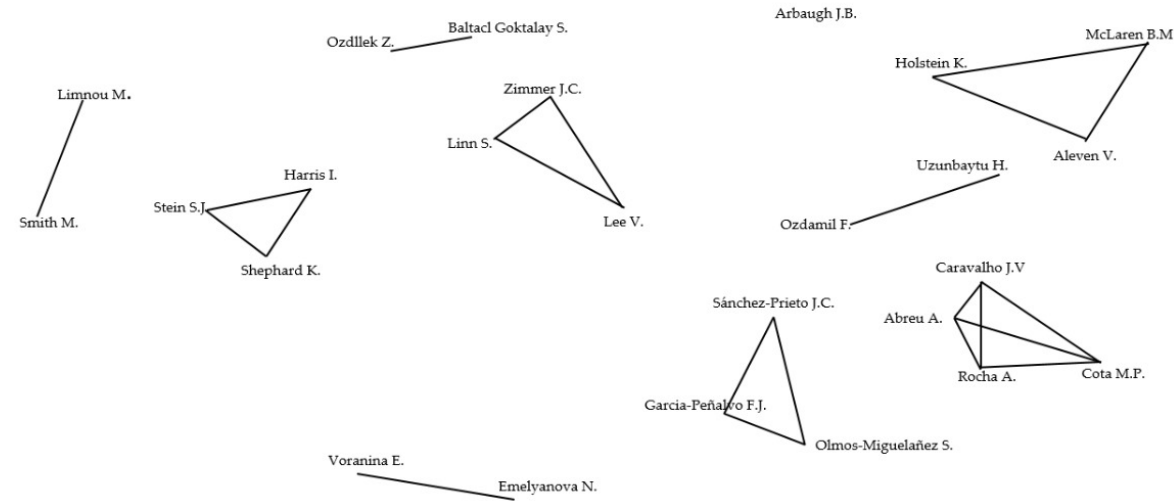
Figure 7. Network of the most cited authors. Own elaboration based on SCOPUS data.